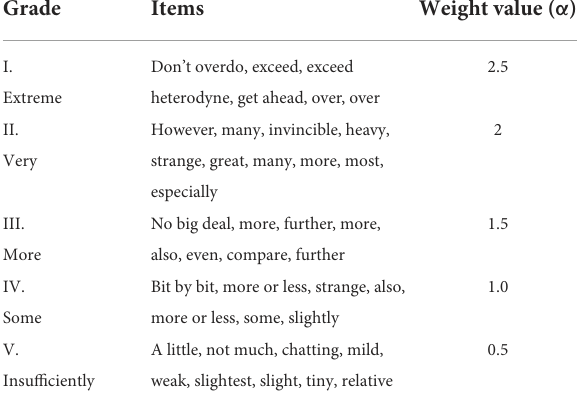
TABLE 2 Dictionary of degree adverbs of express service defects